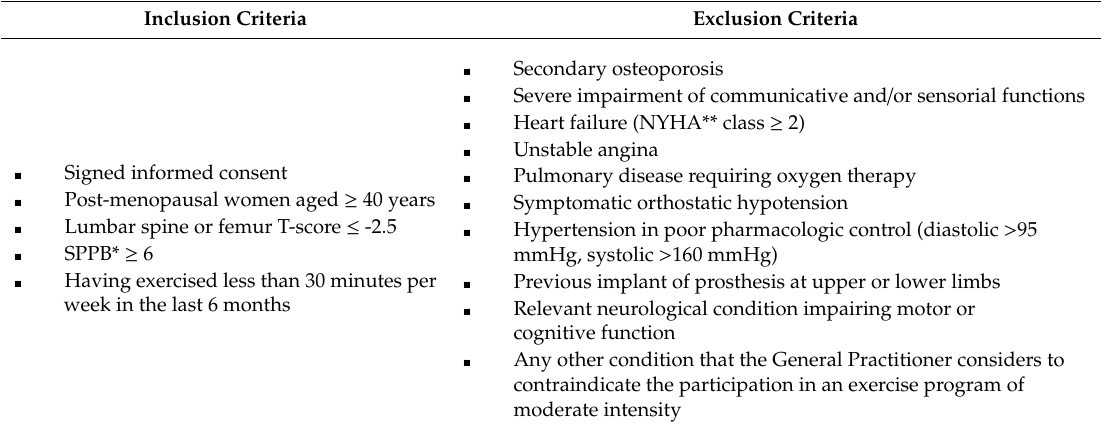
Table 1. Inclusion and exclusion